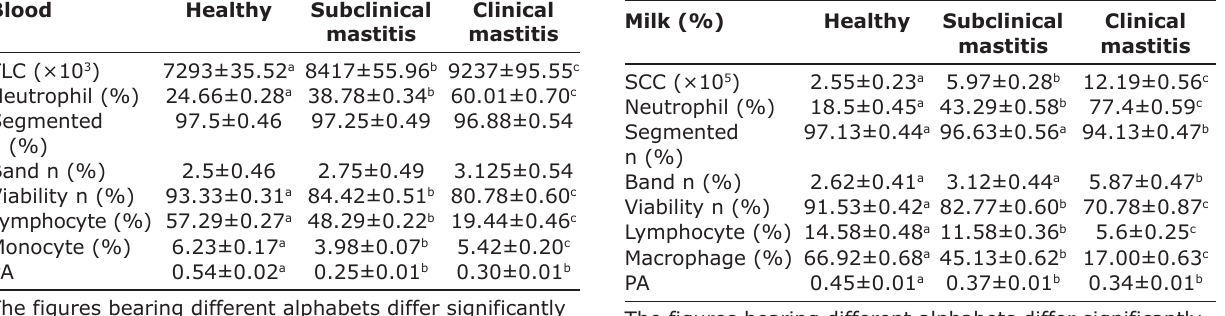
Table-1: Blood TLC, differential leukocyte counts, and phagocytic activity of blood neutrophils in healthy, subclinical, and clinically infected KF cows.